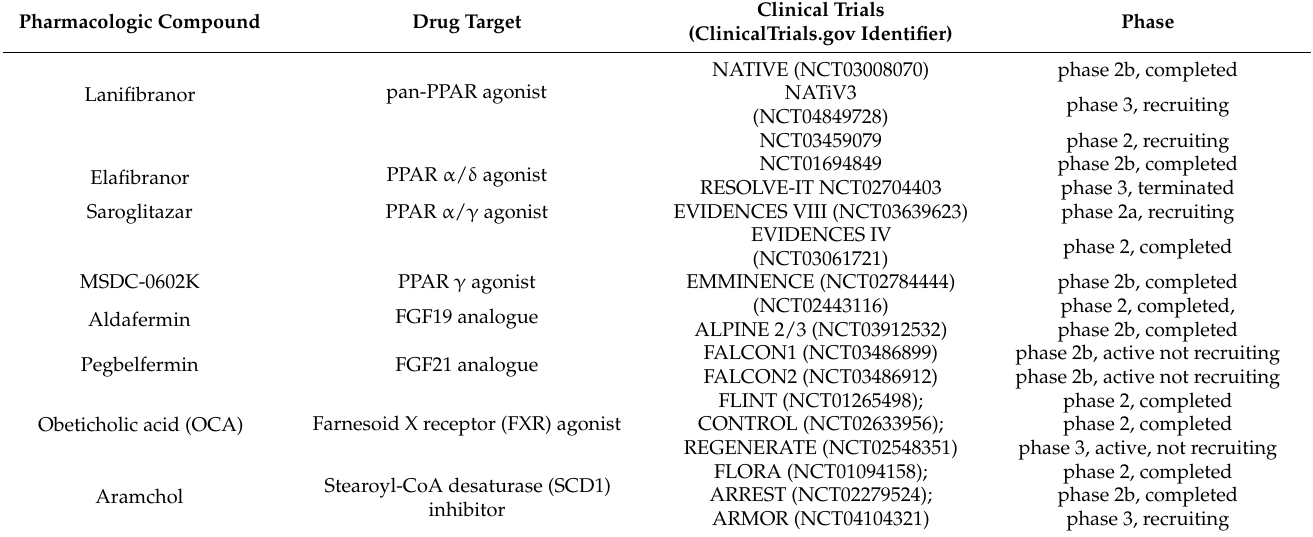
Table 1. Selected pharmacologic compounds targeting nuclear receptors in Nonalcoholic fatty liver disease